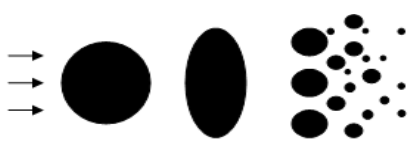
Figure 3. Schematic of droplet secondary breakup.